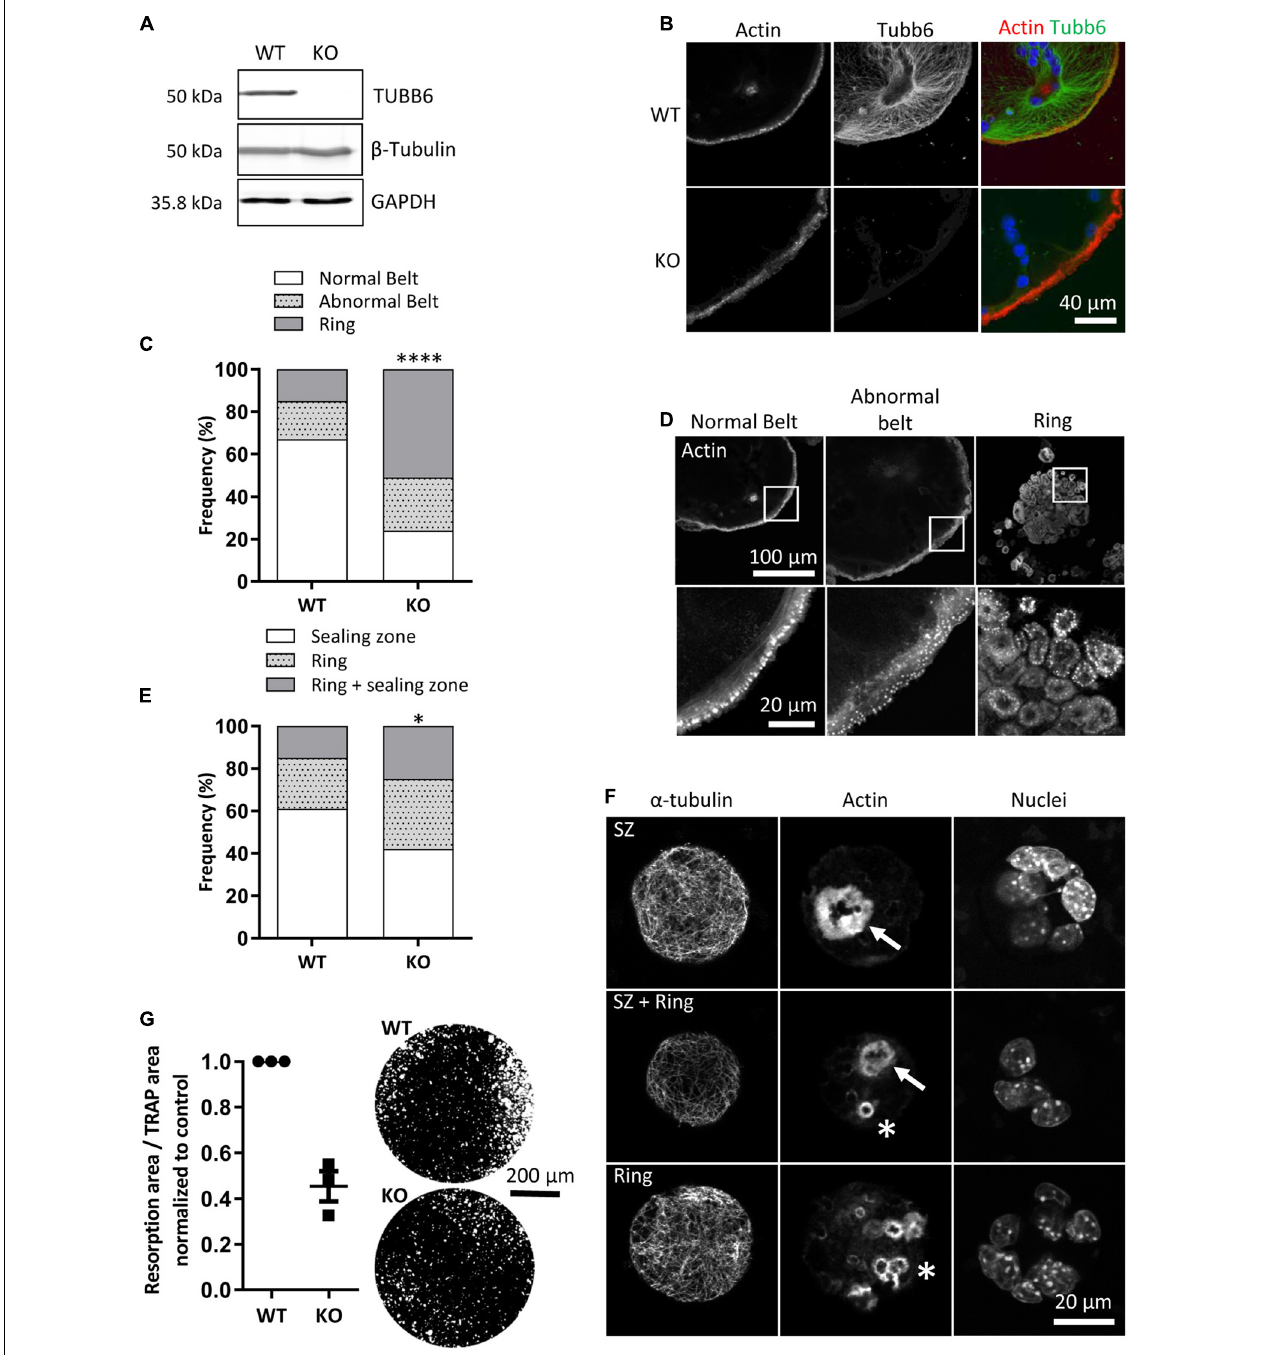
FIGURE 1 | Tubb6 gene knockout alters osteoclast actin cytoskeleton and activity. (A) Representative immunoblot analyses of lysates from wild type (WT) and Tubb6 KO (KO) osteoclasts. GAPDH control shows that total β -tubulin levels are not affected in osteoclasts that do not express TUBB6. (B) Representative maximum intensity projection (MIP) confocal images of WT and KO osteoclasts seeded on glass and stained for endogenous F-actin and TUBB6. (C) Bar graph showing the frequency of WT and KO osteoclasts seeded on glass and presenting podosome rings, a normal or an abnormal podosome belt, counting more than 200 WT and KO osteoclasts in four independent experiments, χ 2 contingency test, ∗∗∗∗ p < 0.0001. (D) Representative MIP images illustrating the different categories of actin organization considered in (C) . (E) Bar graph showing the frequency of WT and KO osteoclasts seeded on mineral matrix and presenting either sealing zones (SZ), or rings or both, counting more than 150 WT and KO osteoclasts in three independent experiments, χ 2 contingency test, ∗ p < 0.05. (F) Representative MIP images illustrating the different categories of actin organization considered in (E) , with SZ and rings respectively indicated with arrows and stars respectively. (G) Graph showing the average and SEM specific resorption activity of KO osteoclasts normalized to the activity of WT osteoclasts in three independent experiments, 4 wells per experiments. Representative image of von Kossa staining of the resorption wells are presented on the right.